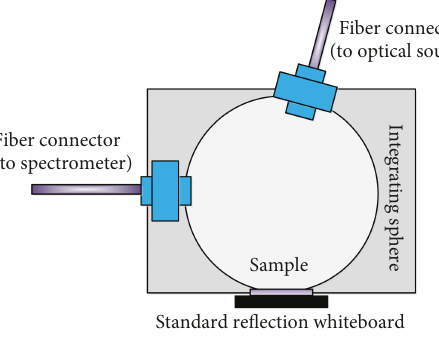
Figure 15: Set-up diagram for measuring di ff use re fl ection spectrum.